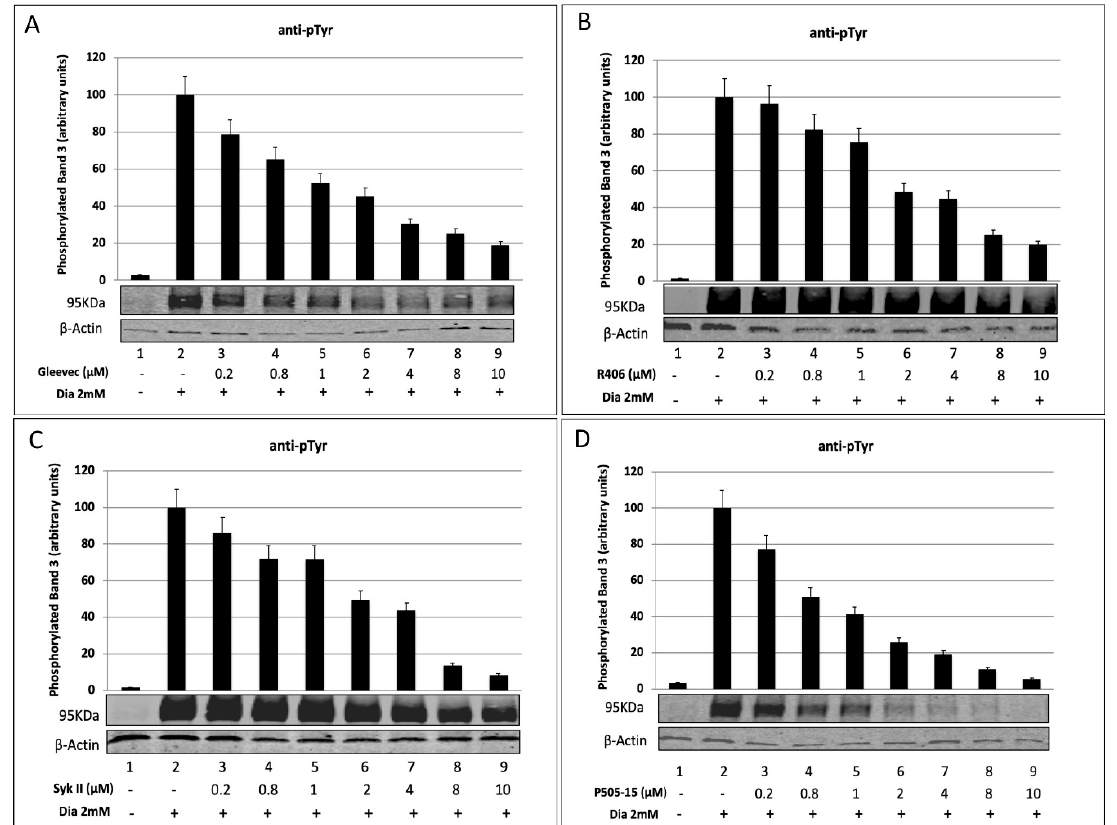
Figure 2. Dose–response course of erythrocyte membrane proteins treated with an oxidant agent and Syk inhibitors related to quantitative analysis of band 3 tyrosine phosphorylation. Erythrocytes were treated with 2 mM diamide (Dia) and different concentrations of the Syk inhibitors (0–10 µM) ( A ) Gleevec, ( B ) R406, ( C ) Syk II, and ( D ) P505-15. Lane 1 shows the untreateded control sample. Erythrocytes were separated by 8% SDS-PAGE, blotted on a nitrocellulose membrane, and stained with antiphosphotyrosine (apTyr) antibodies. Images were acquired using a laser IR fluorescence detector (Odyssey, Licor, USA). Band 3 Tyr phosphorylation was quantified using Image J software. Values are the means ± for four independent experiments, normalized to total beta-actin levels. All graphs show relative phosphorylation, expressed as a percentage of the maximum observed in each experiment (100%). The error bars represent the standard deviation (SD) of the data.